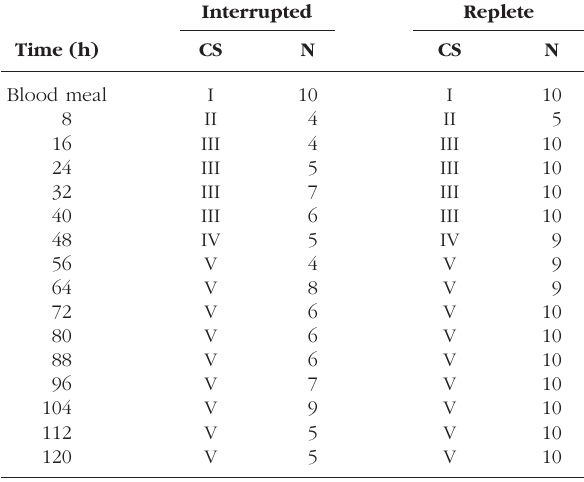
Table I. – First experiment: Christophers’ stages according to time for replete females (full blood meal) and females with an interrupted blood meal. N is the female number that reached the Christophers’ stage (CS) on the 10 dissected